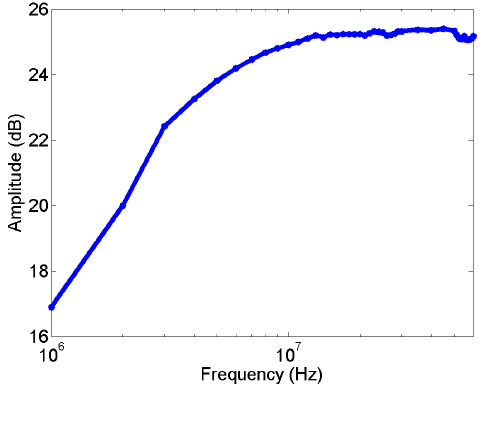
Figure 5. Experimental frequency response of the HFCT.